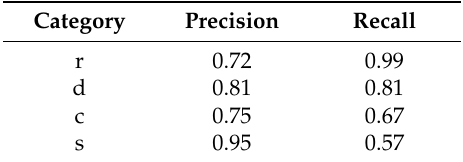
Table 2. Precision and recall for each food category using the evaluation set.